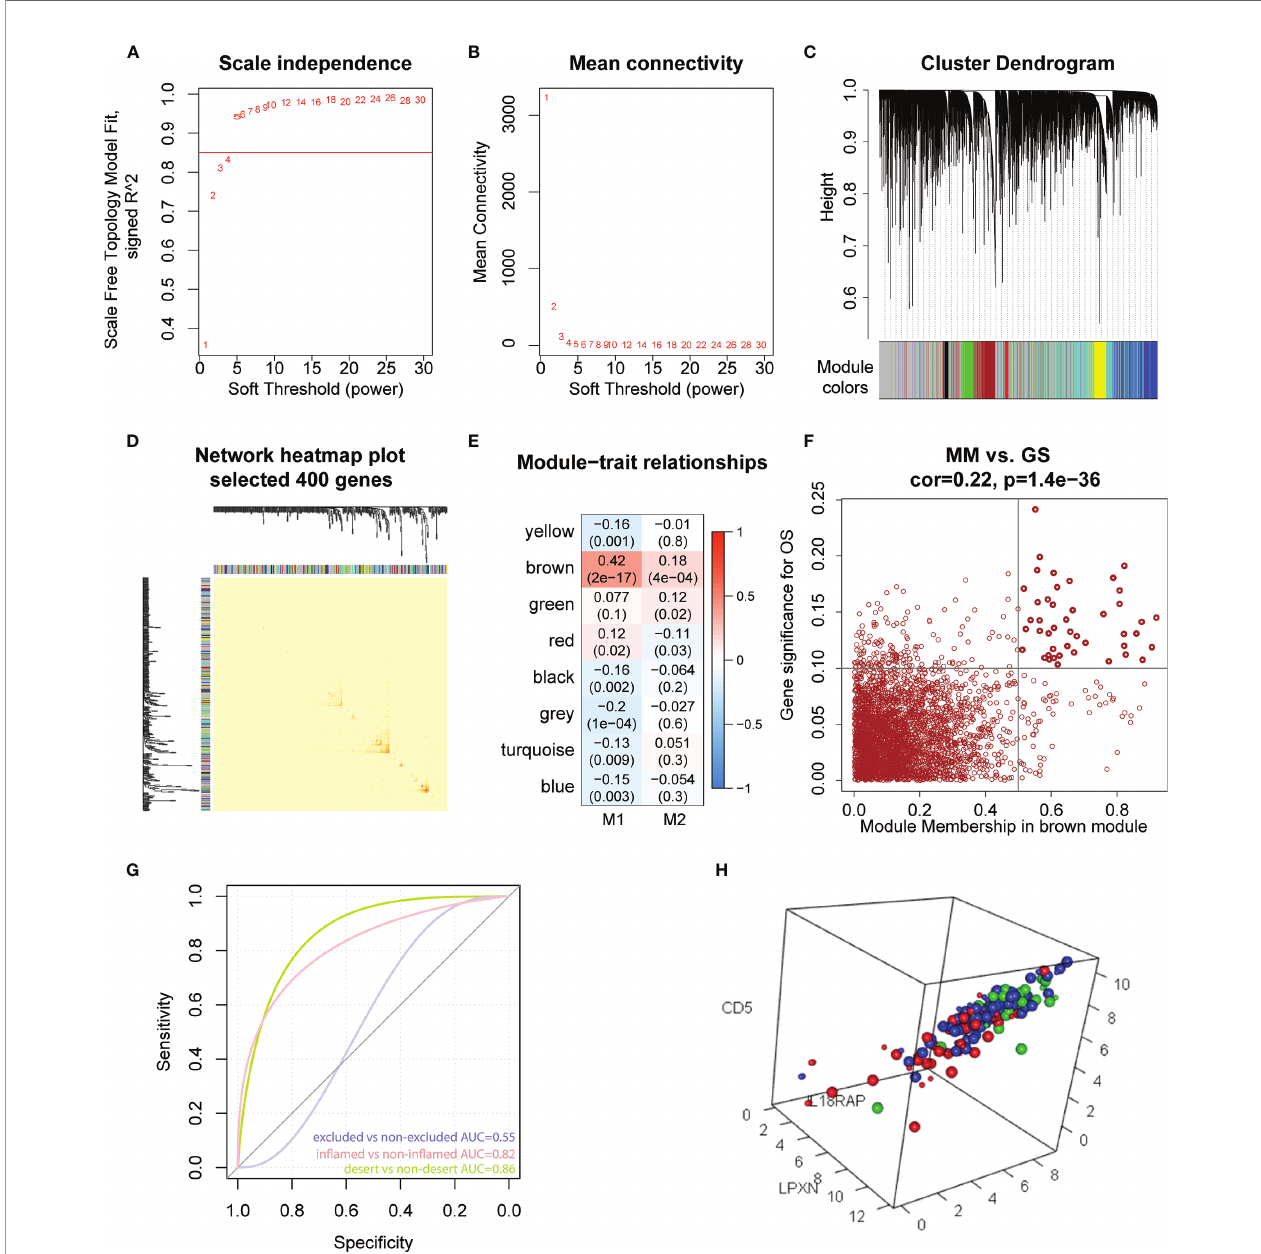
FIGURE 5 | Hub genes screening and immunotherapy prediction. (A) The nature of the network topology constructed with unique Power values. (B) The relationship between Power values and average connectivity. (C) Genes are clustered into discrete modules. (D) Four hundred genes were randomly selected and clustered into distinct modules. (E) The correlation between different modules and the proportion of M1 and M2-like myeloid cells. (F) In the brown module, the correlation between genes and overall survival was reported as scatter plot, and the dark dots were hub nodes. (G) predicting AUC (Area Under Curve) of three phenotypes. (H) Different colors represented different types: Large dots represented support vector, red represented desert samples, blue represented excluded- samples, and green represented in fl amed